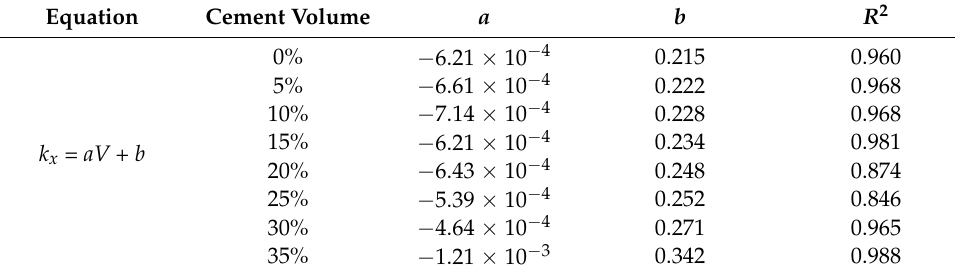
Figure 2. The relationship between water resistance coefficient and foam volume. Table 4. The fitting results of water resistance coefficient and foam volume.